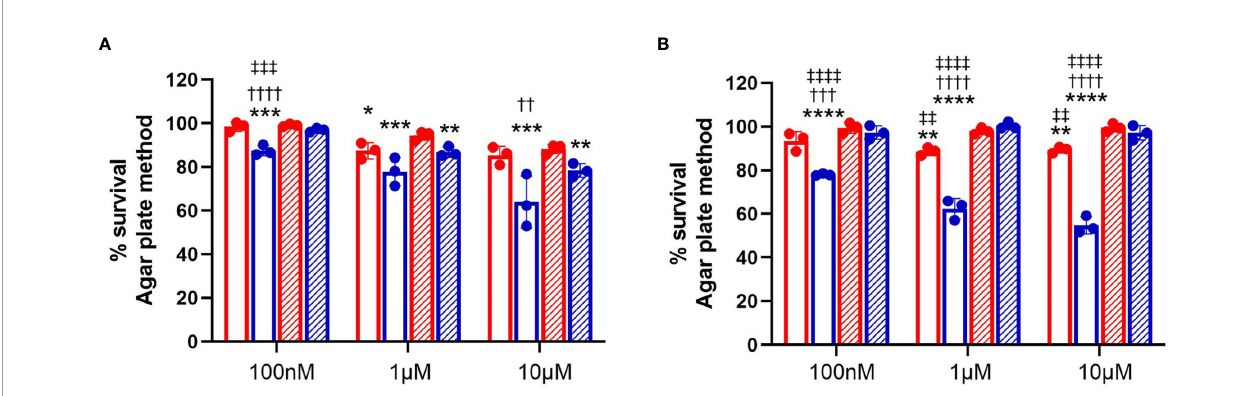
FIGURE 5 | Bactericidal activity of chlorolipids. 50x10 6 /ml of CFT073 (red) and JM109 (blue) cells were incubated with indicated concentrations of either 2- chlorohexadecanal (clear bars, A ), hexadecanal (hatched bars, A ), 2-chloropalmitic acid (clear bars, B ), or palmitic acid (hatched bars, B ) for 1hr at 37°C. Bacterial survival (%) was determined by calculating CFU/ml over vehicle control bacteria. Values represent the mean ± SD for n=3. Statistics were performed ANOVA within each concentration tested. p-value: ****< 0.0001; ***< 0.001; **< 0.01; *< 0.05 for comparisons for each lipid compared to control (no lipid addition). †††† < 0.0001; ††† < 0.001; †† < 0.01 for comparisons at each concentration for each lipid between treatments of JM109 and CFT073 cells. ‡‡‡‡ < 0.0001; ‡‡‡ < 0.001; ‡‡ < 0.01 for comparisons at each concentration between chlorolipid and non-chlorolipid